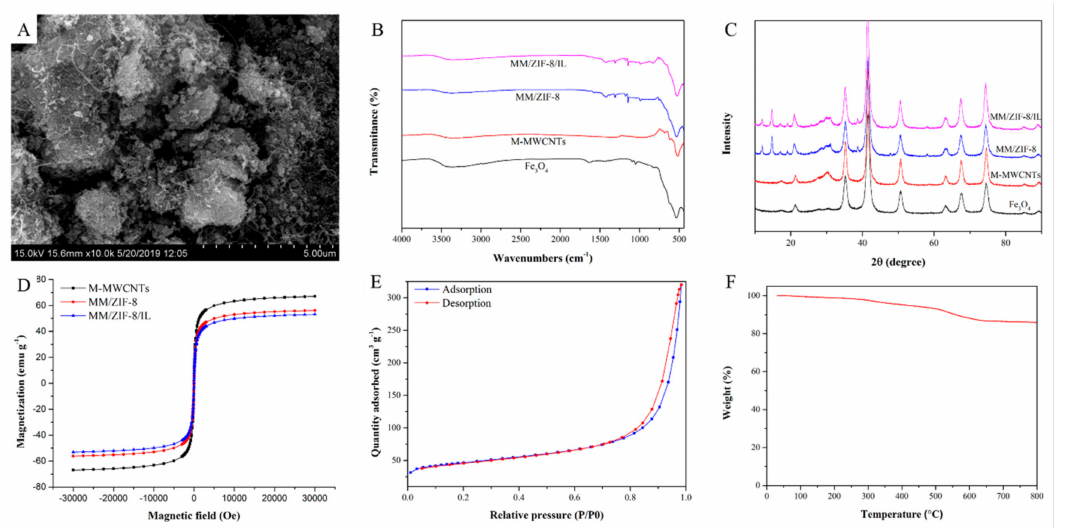
Figure 1. Characterization of the synthetic materials. ( A ) SEM image of magnetic multiwalled carbon nanotube / zeolitic imidazolate framework-8 ionic liquid (MM / ZIF-8 / IL); ( B ) FT-IR spectra, ( C ) XRD patterns, and ( D ) magnetic curves of the synthetic materials; ( E ) N 2 adsorption–desorption isotherm; and ( F ) TGA curve of the MM / ZIF-8 /